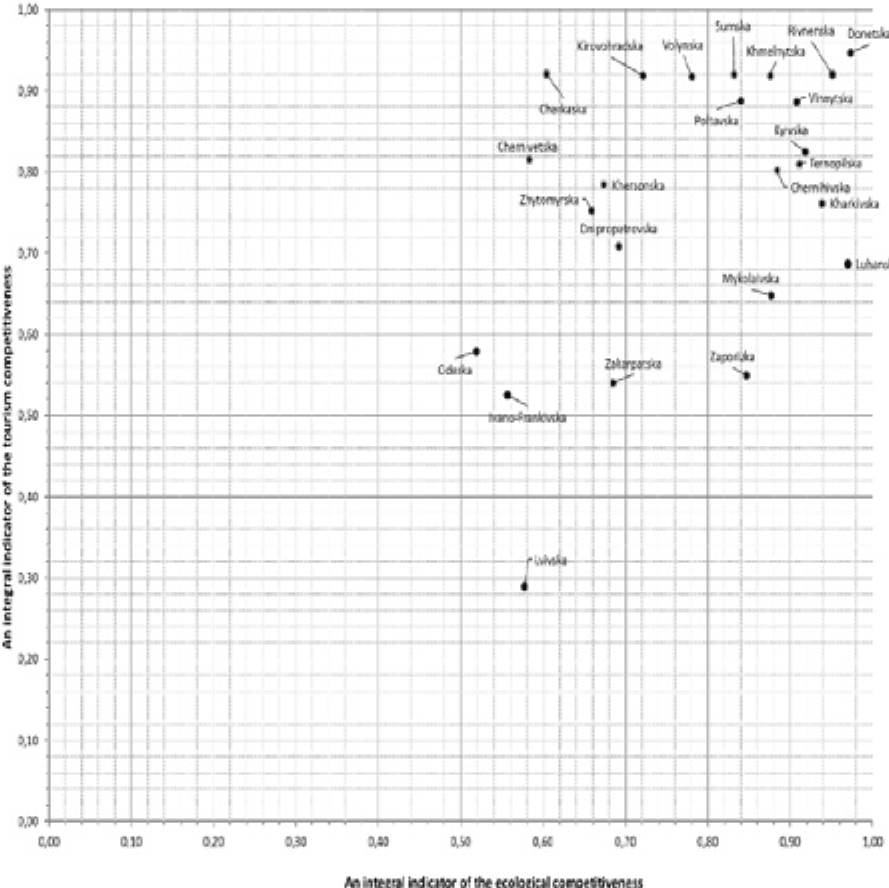
Fig. 3: The matrix of green tourism potential in 2020 (Ukraine’s regions)